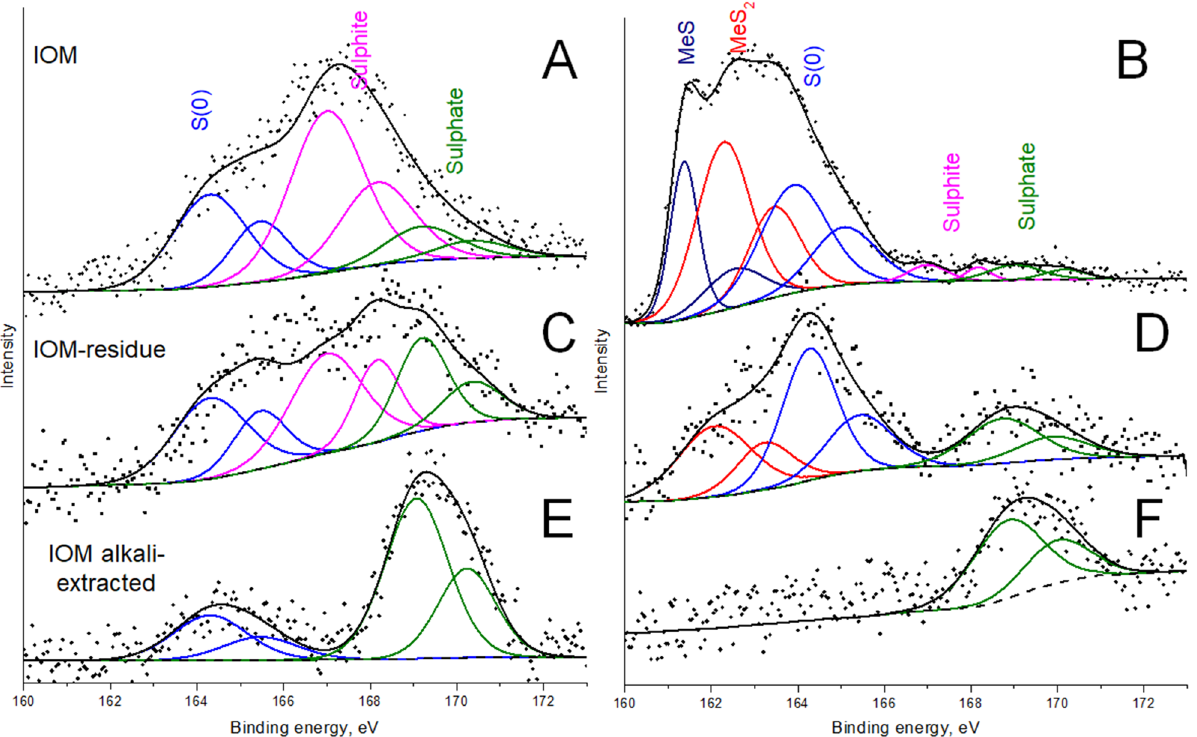
Figure 1. XPS spectra of the IOM fractions. Left and right panels show results for Murchison and Allende,